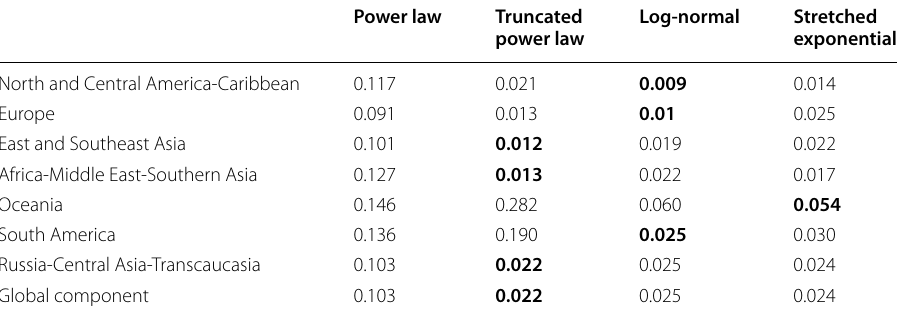
Table 5 Kolmogorov–Smirnov goodness of fit values (KS-test) for the degree-degree distance